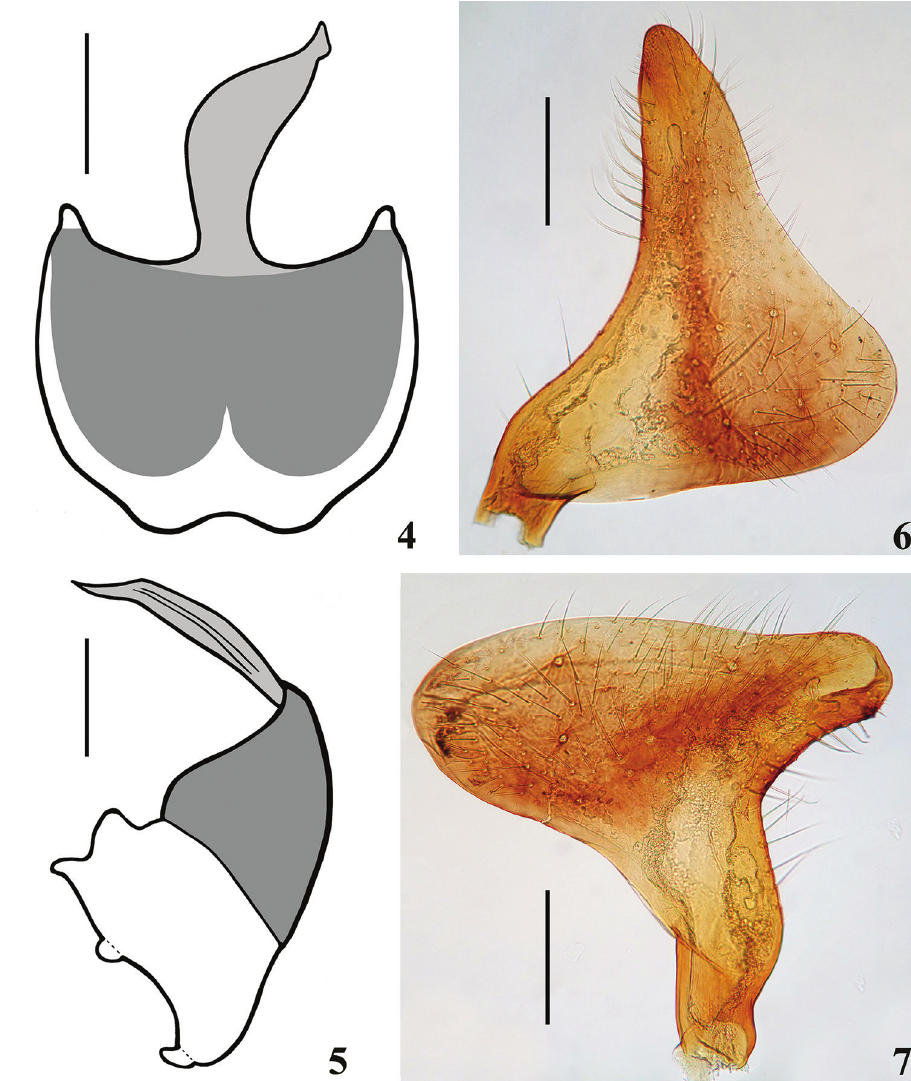
with a half-hemispherical process ( hhp ) inside its apical portion (Figs 10–14), which is covered by several small sclerotized components, some of which are acutely spined (Fig. 16). Endosoma wall with a small rounded globose lobe laterally ( gl ), located just ventrally to apex of larger flat lateral expansion of dorsal phallothecal sclerite (Figs 12, 14). Female. Figure 18. Measurements: total length to tip of abdomen: 12.5; abdomen maximum width: 4.0. Similar to male. Hemelytra not surpassing abdomen,